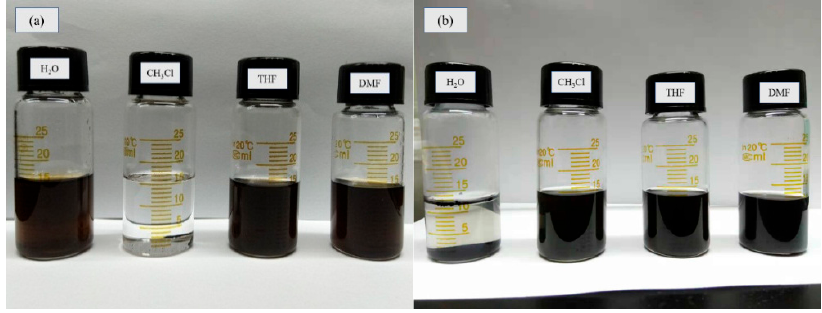
Figure 7. GO ( a ) and GO-MD-MP ( b ) in different solvents.